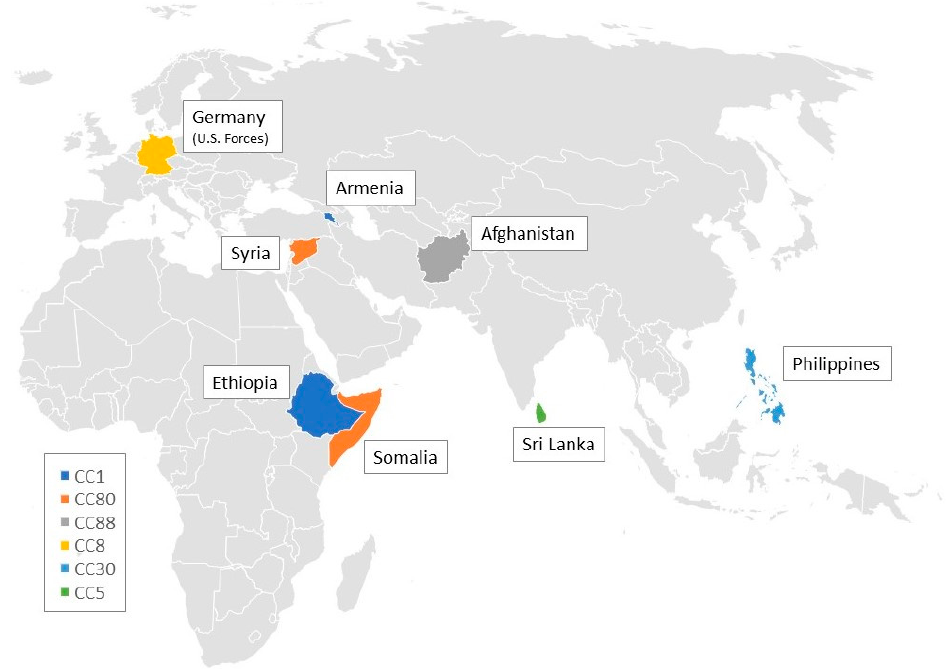
Figure 3. Geographical map illustrating the origins of clonal complexes associated with travel and migration in this study.